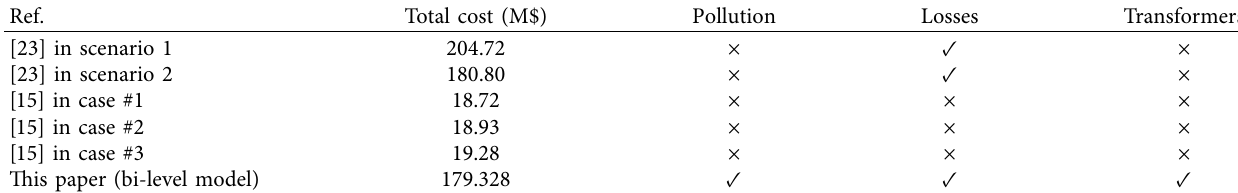
Table 11: The obtained results for the case studies.